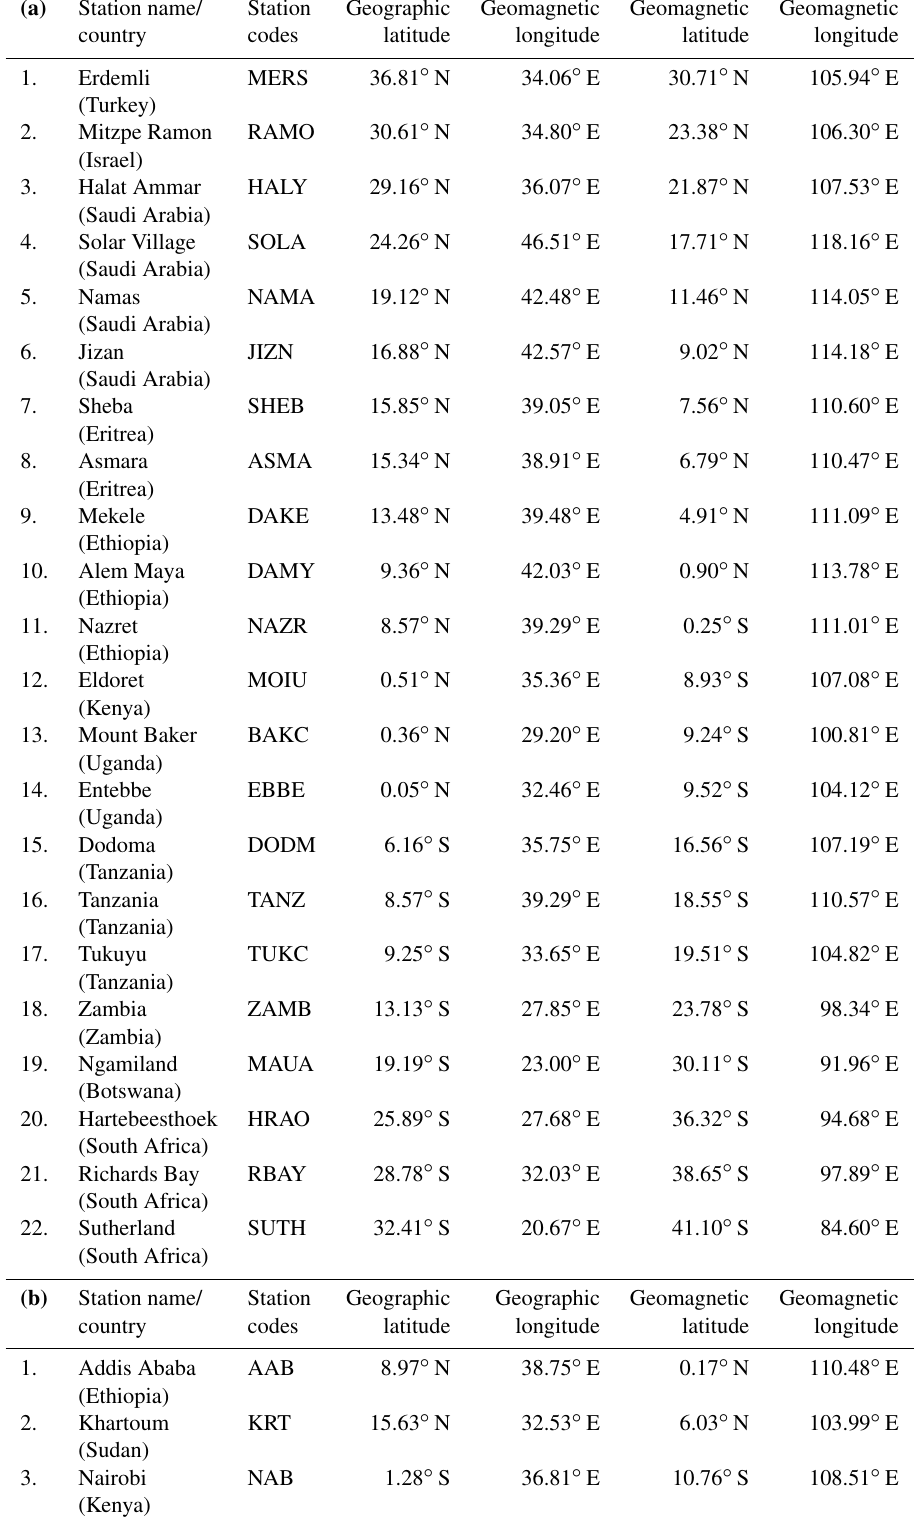
Table 1. (a) Names and coordinates of the GPS stations under investigation. (b) Names and coordinates of MAGDAS stations used in this